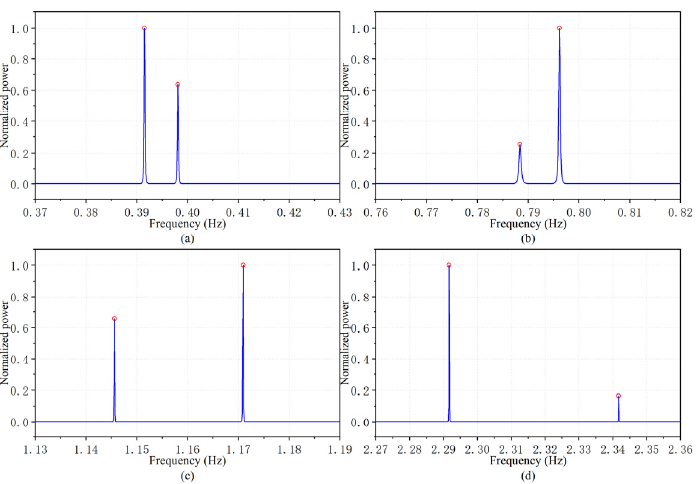
Figure 6. The results obtained by SFFT-IAA (SRN = 30). The red circles indicate estimated frequencies. ( a ) Frequency band [0.37 Hz 0.43 Hz]; ( b ) Frequency band [0.76 Hz 0.82 Hz]; ( c ) Frequency band [1.12 Hz 1.19 Hz]; ( d ) Frequency band [2.27 Hz 2.36 Hz].